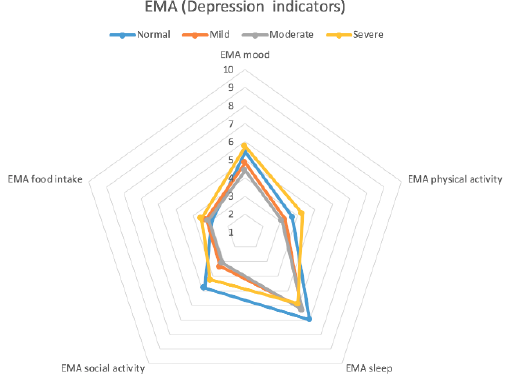
Figure 8. Distribution of feature importance per feature for all personal models for classification of physical activity and mood levels.